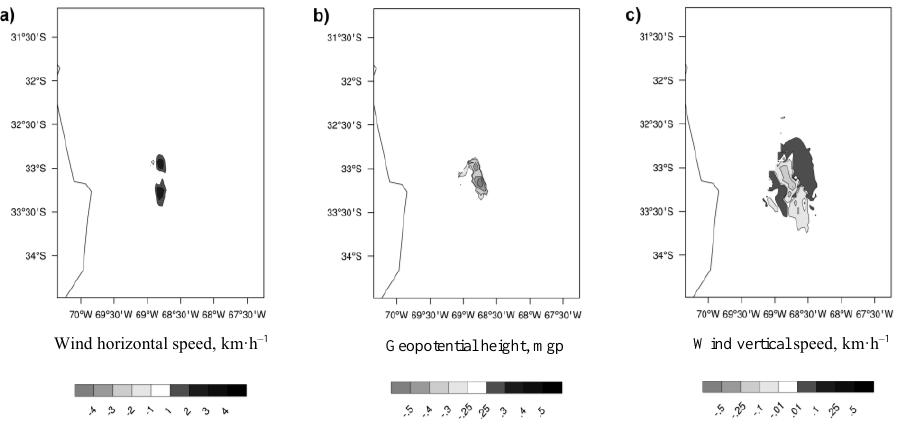
Fig. 14. Anomaly calculated as ID5 − Test_Control at 2 km a.s.l. on January 8, 2012 at 11:00 LT for: a) wind horizontal speed; b) geopotential height; c) wind